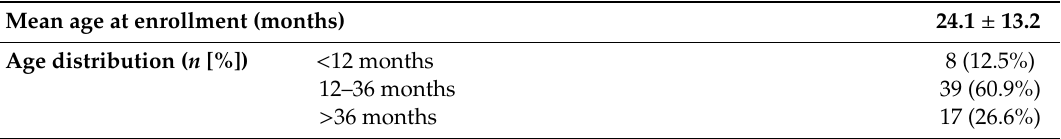
Table 1. Age range and diagnostic criteria for cow’s milk protein allergy (CMPA) in the modified intention-to-treat (mITT) cohort ( n =